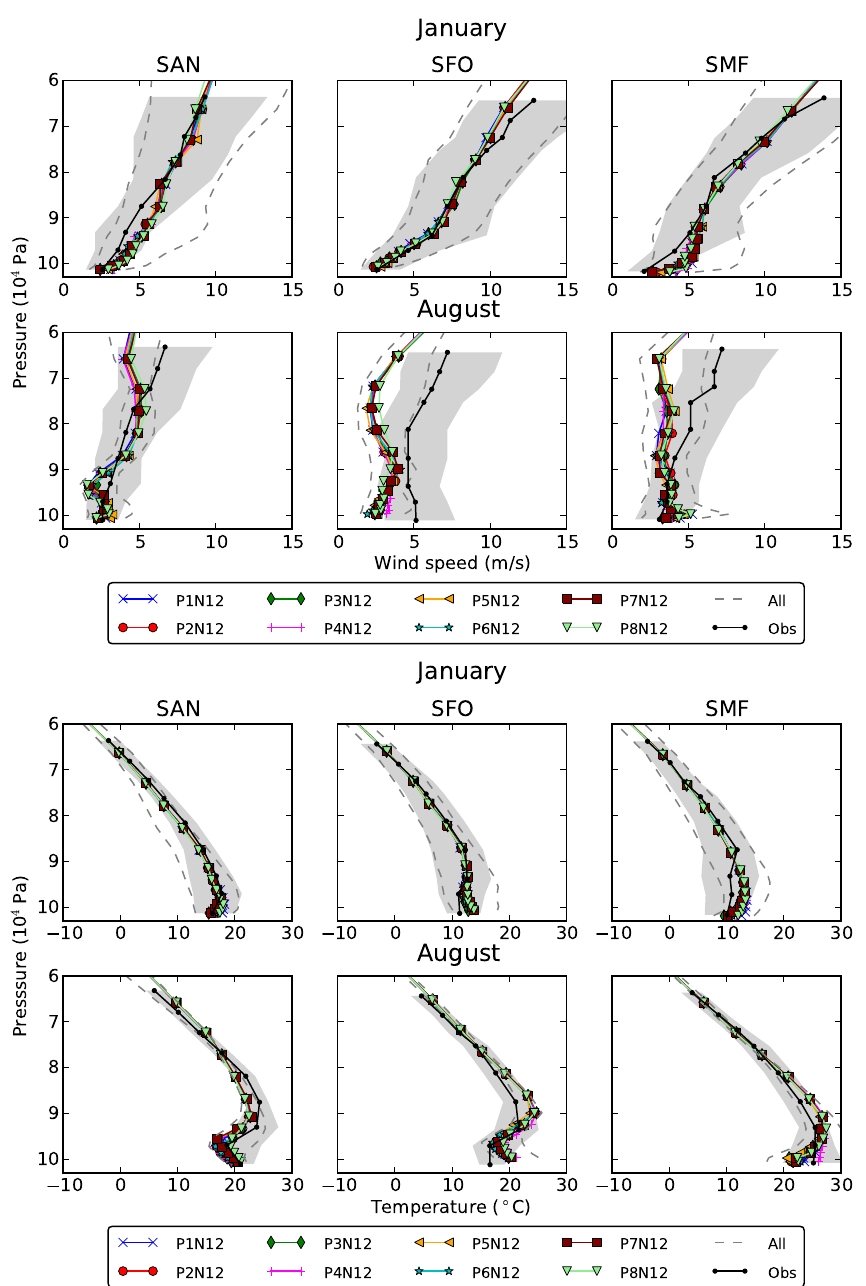
Fig. 5. Vertical profiles of the monthly median wind speed and temperature averaged over January and August 2009 for the eight PBL schemes and the observations at three of the airports (SAN, SFO and SMF). The profiles go from ground to around 4km. The grey envelope represents the upper and lower quartiles of the observations. The grey dotted line shows the upper and lower quartiles for all the simulations together.